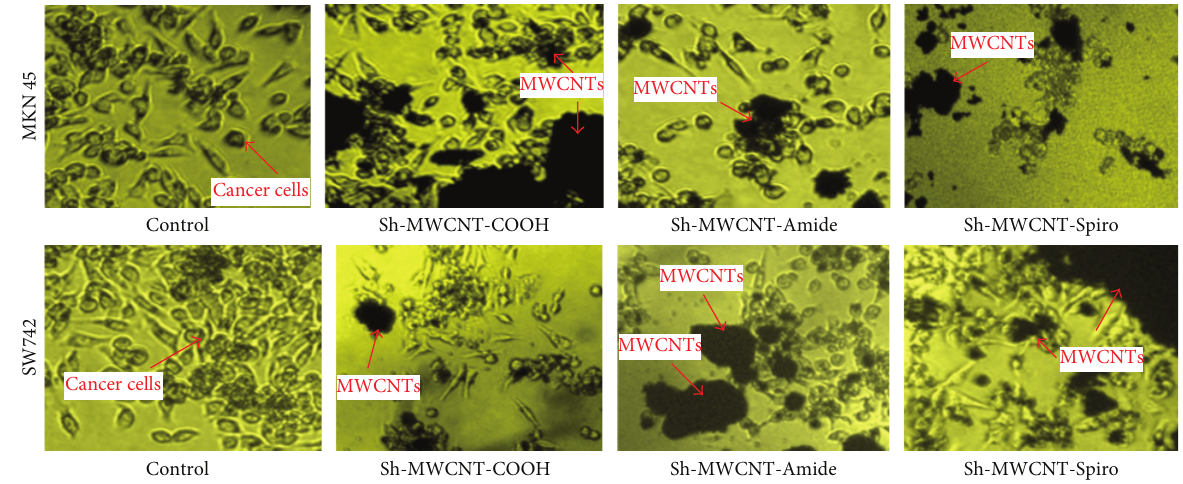
Figure 7: The growth of MKN45 and SW742 cancer cells on the